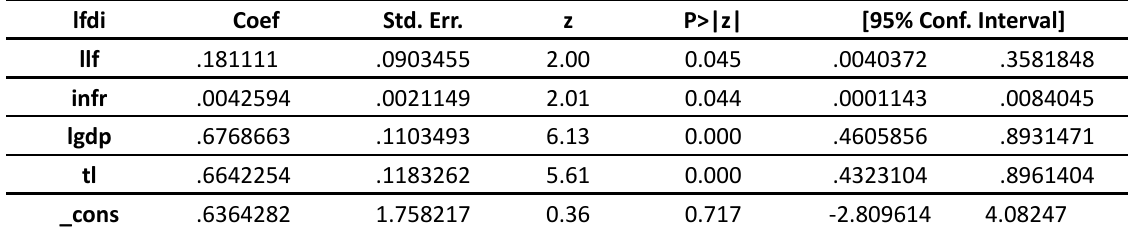
Table 2: Regression